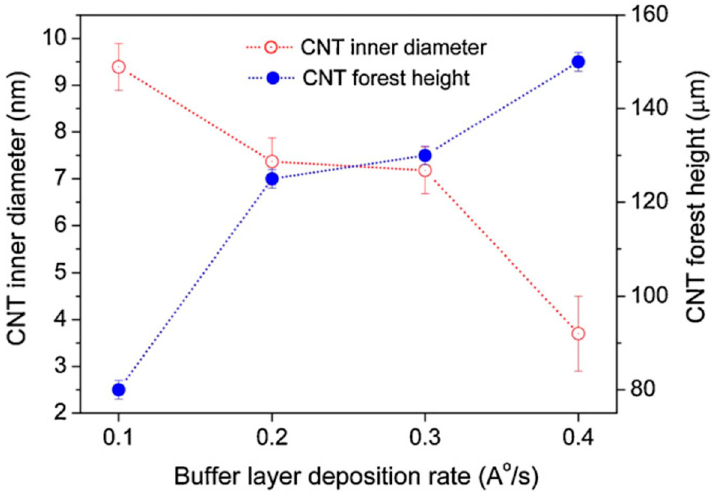
Figure 3. Al DBL deposited at defined rates over the inner diameter and height of grown VACNT. Reprinted with permission from Patole, Applied Surface Science; Ref. [68] copyright 2013, Elsevier.